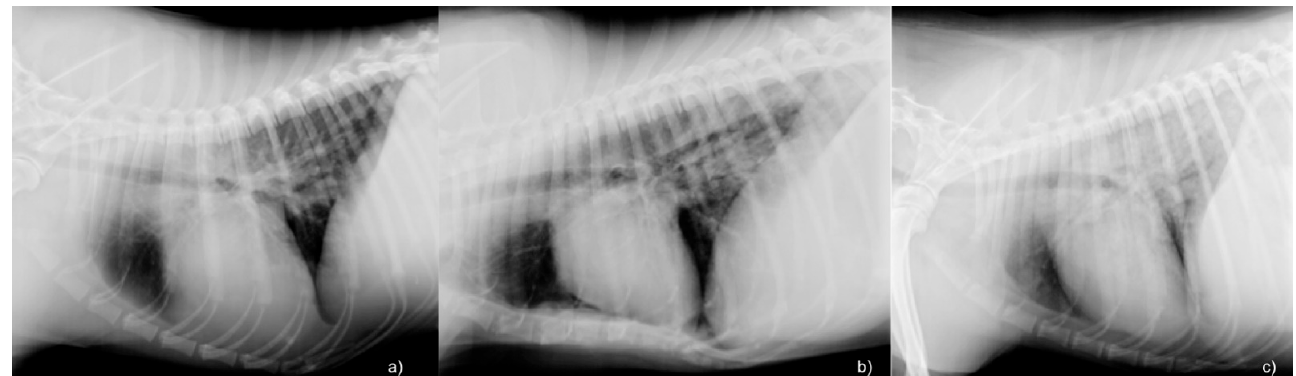
Figure 1. Radiographic pulmonary patterns of three dogs with radiographic abnormalities. Right lateral thoracic radio- graphs of three different dogs affected by leptospirosis, showing the three radiographic pulmonary patterns observed in the study; in these patients the pattern had a caudal distribution: ( a ) unstructured interstitial pattern ( b ) interstitial-alveolar pattern; ( c ) alveolar pattern.